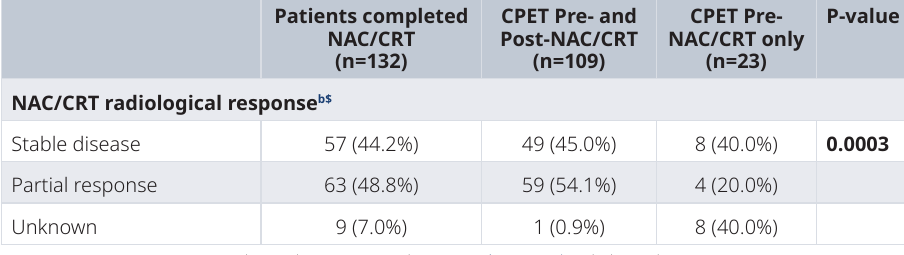
Table 3. Cardiopulmonary exercise testing (CPET) variables before and after neoadjuvant chemotherapy (NAC) and chemoradiotherapy (CRT). VO at AT (ml.min -1 ) 2